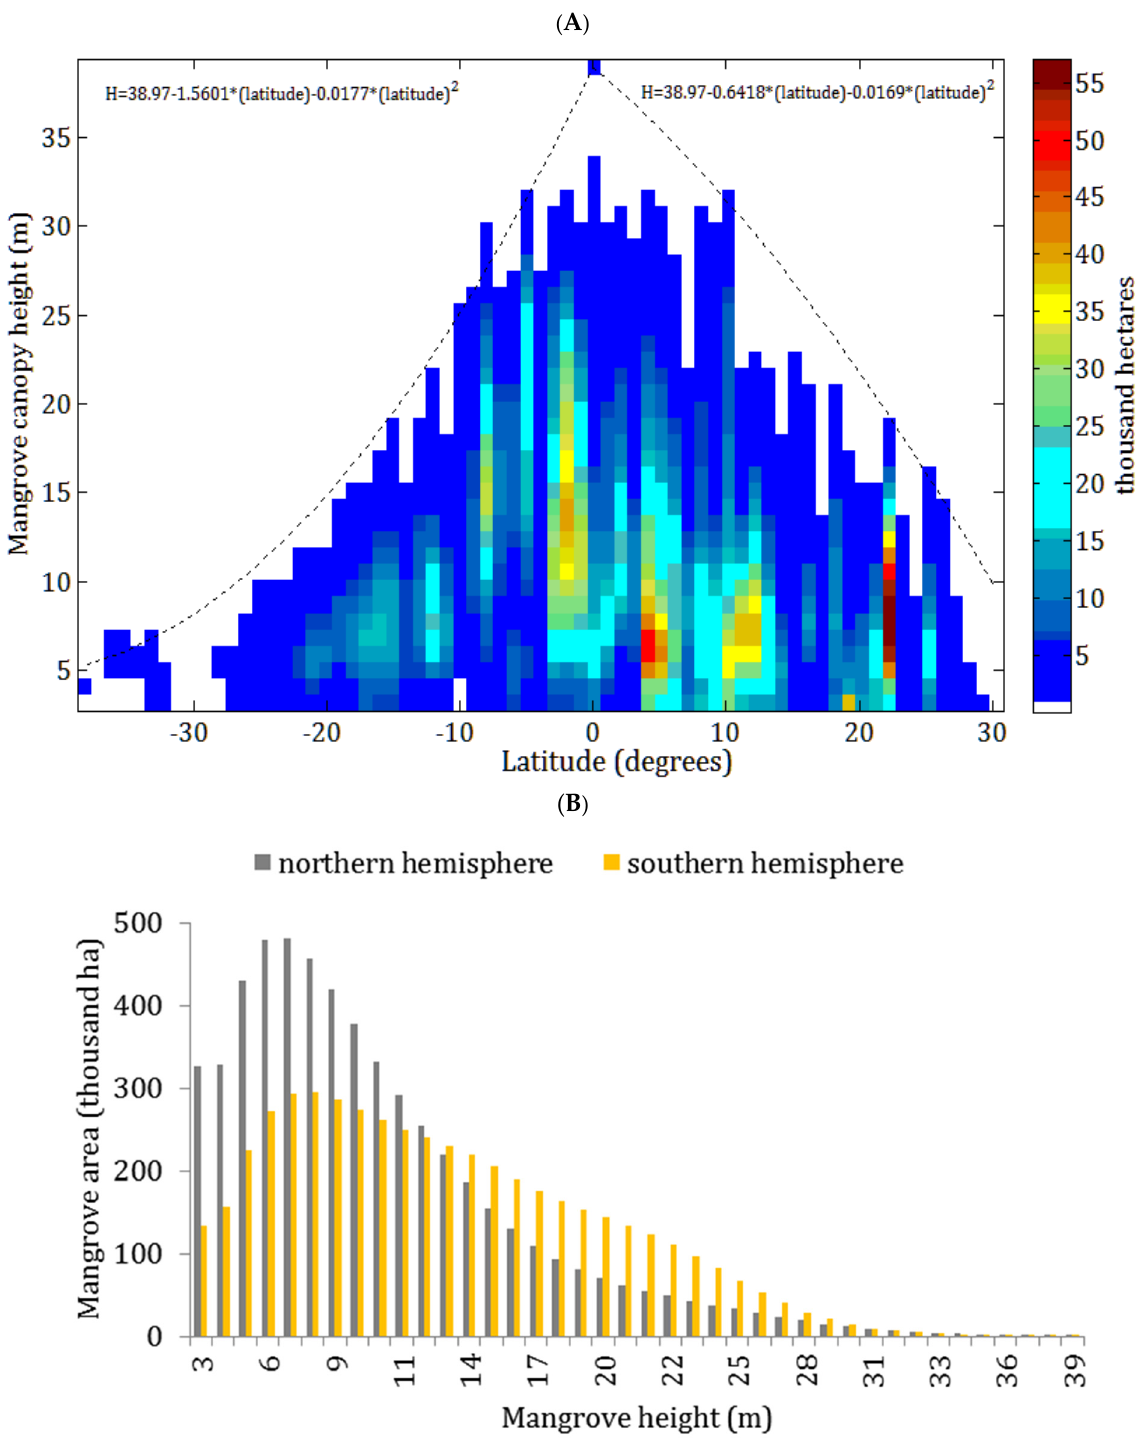
Figure 3. Mangrove height distribution across different latitudes and height classes: ( A ) latitudinal distribution (38 ◦ S to 30 ◦ N) of mangrove canopy heights and the areas occupied by each height class are shown. For clarity of display, the latitudes are binned at 1 ◦ and the heights are binned at 1 m. The tallest mangroves were located near the equator, and the maximum height of mangroves declined in both hemispheres as the distance from the equator increased. Areal coverages of mangroves at each latitude and height class are shown by the color distribution. ( B ) Mangrove areas at different heights differed for the Northern and Southern